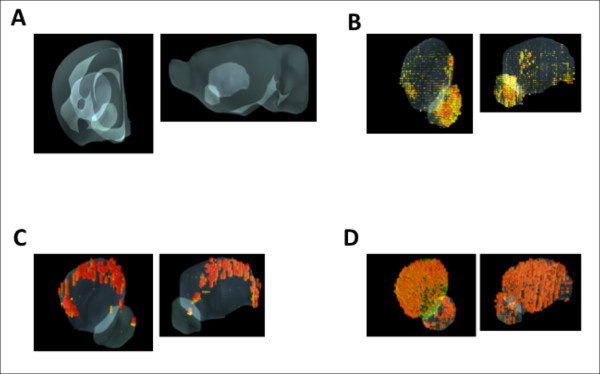
Spatial specificity of modules. (A) Location of the caudoputamen and nucleus accumbens within the mouse brain. Left, coronal section; right, saggital section. (B-D) The midnight blue, purple and red modules, respectively. The ten genes closest to the module eigengene are selected for each module, and their expression is superimposed. For visual clarity, only the areas with medium-high expression intensity are shown, with the darker red signifying high intensity of the hybridization signal (see Methods).